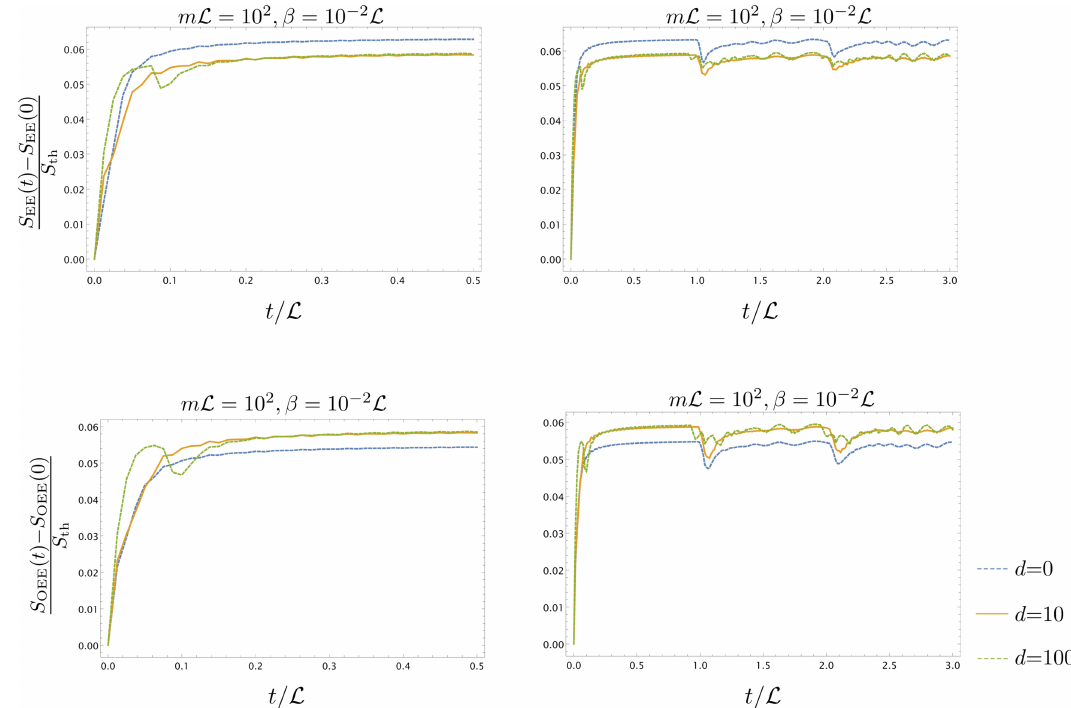
Figure 17 . Mass effect on time evolution of S EE (upper panels) and S OEE (bottom panels). We take N =1501 and N